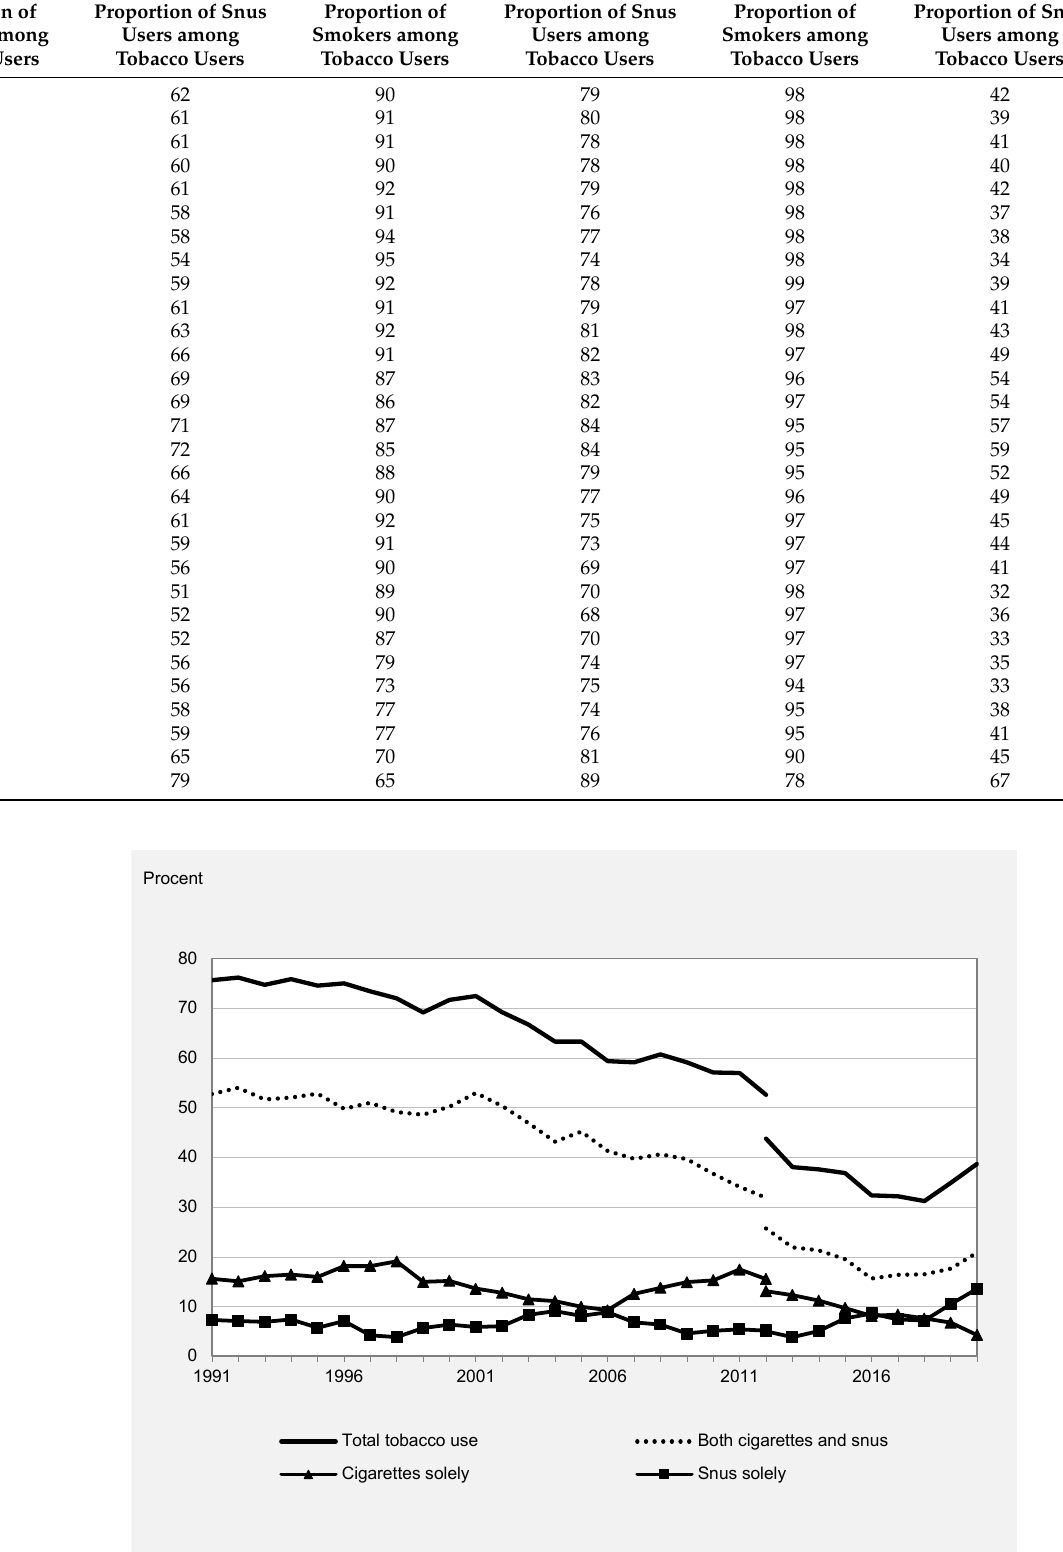
Table 2. The proportion of smokers and snus users among tobacco users, 1991–2020. Total Males Females